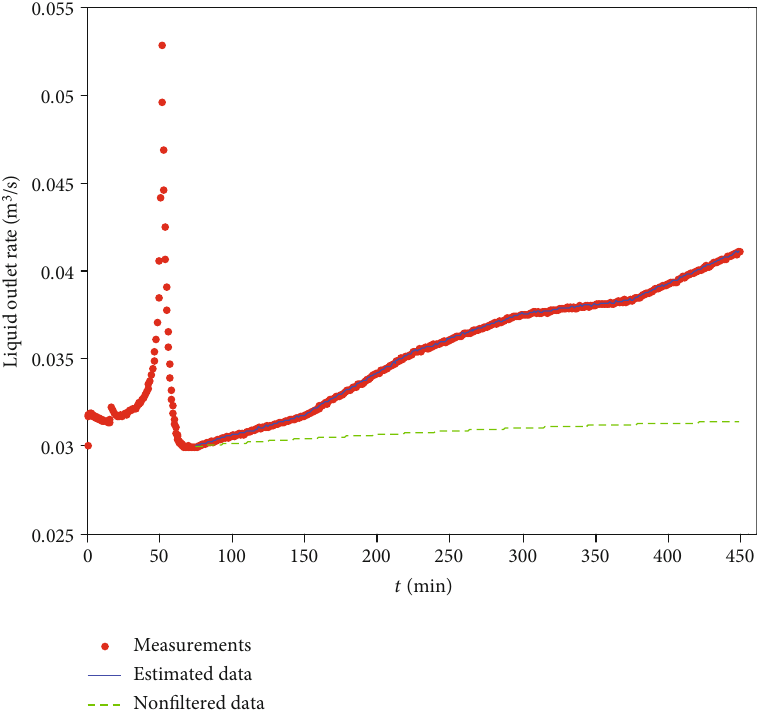
Figure 7: Liquid outlet rate variation (case